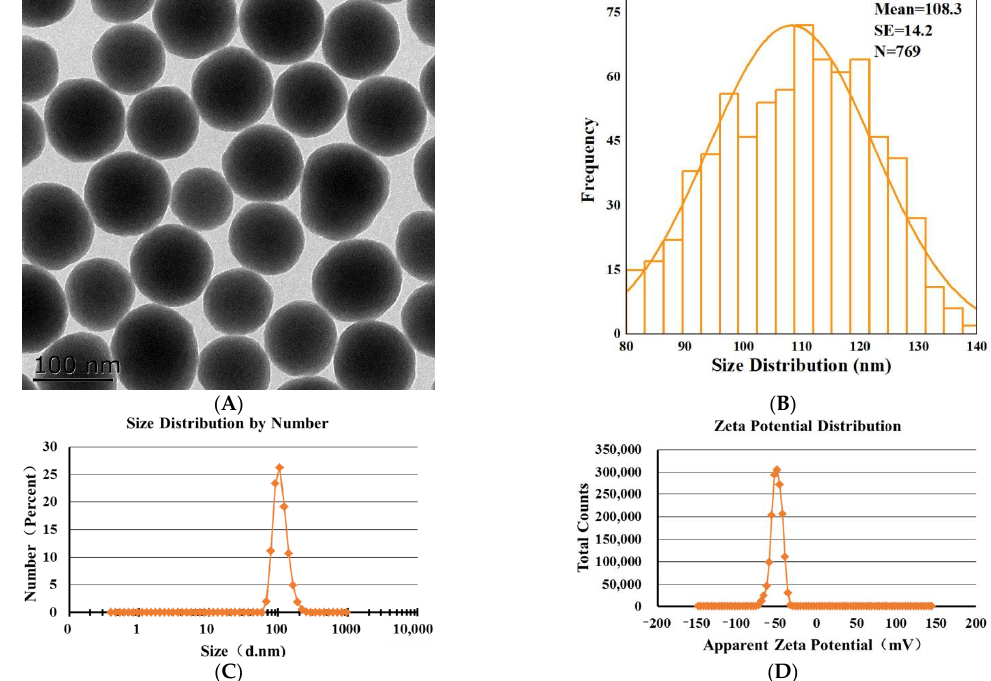
Figure 1. Characterization of SNPs. ( A ) TEM image of SNPs. Scale bar, 100 nm. ( B ) Analysis of the size distribution via Image J software. The average diameter of SNPs was 108.3 ± 14.2 nm. ( C ) The hydrodynamic diameter of SNPs was 110.8 ± 26.5 nm, with a PDI of 0.02 in 10 mM NaCl. ( D ) The apparent zeta potential of SNPs was − 49.7 ± 6.6 mV in 10 mM NaCl.